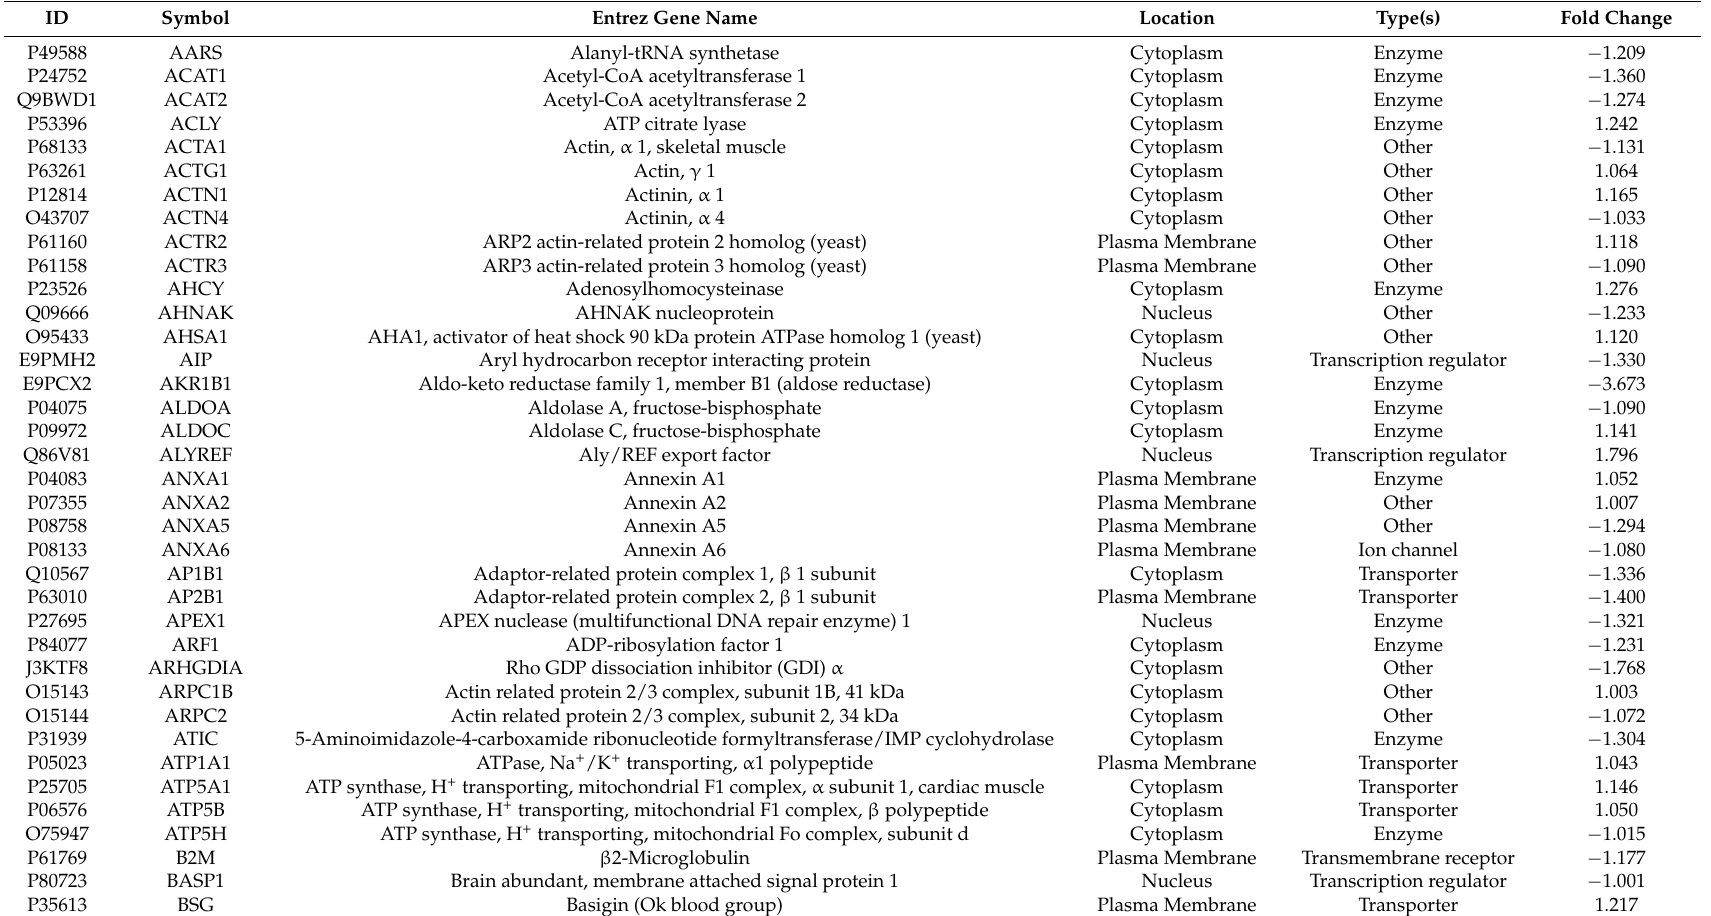
Table 2. 486 mapped molecular proteins by